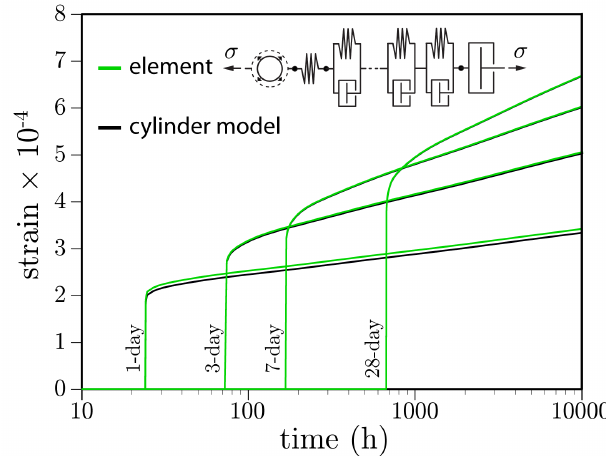
Figure 8. Basic creep curves produced from a single element and from a fully discretized cylindrical specimen.